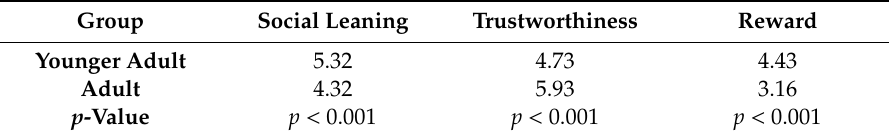
Figure 3. The effect of age on susceptibility to persuasive strategies (SLEARN = social learning, TRUST = trustworthiness, REWD = reward; horizontal bar indicates the neutral of five on the 1–9 Likert scale). Table 4. Between-group analysis based on age.